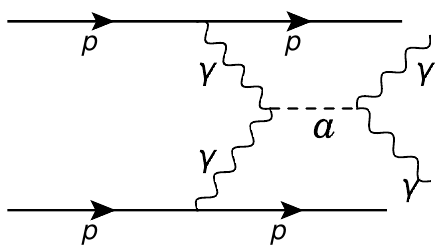
Figure 1 . Schematic diagram of an axion-like particle production in two-photon coherent emis- sion in proton-proton collisions. The scattered intact protons are tagged with the forward proton detectors and the photon pair is detected in the central